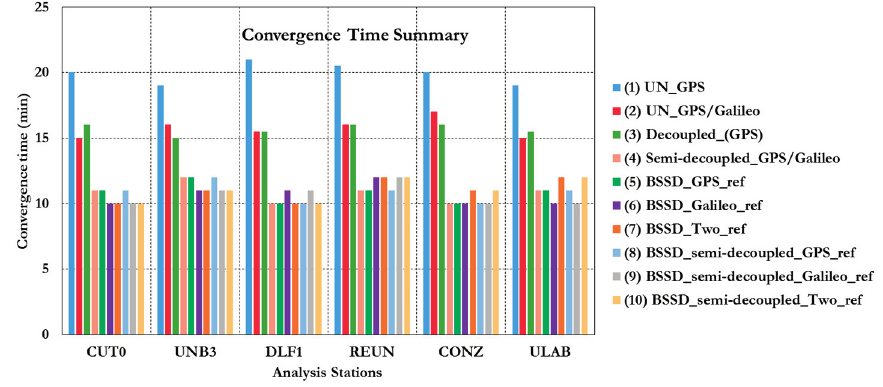
Figure 24. Summary of convergence times of all stations and analysis